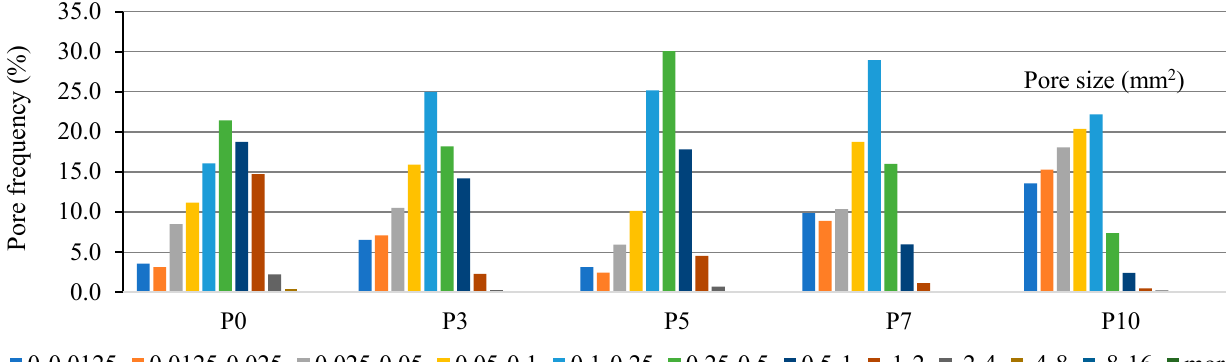
Figure 13. Pore system characterization of specimens.